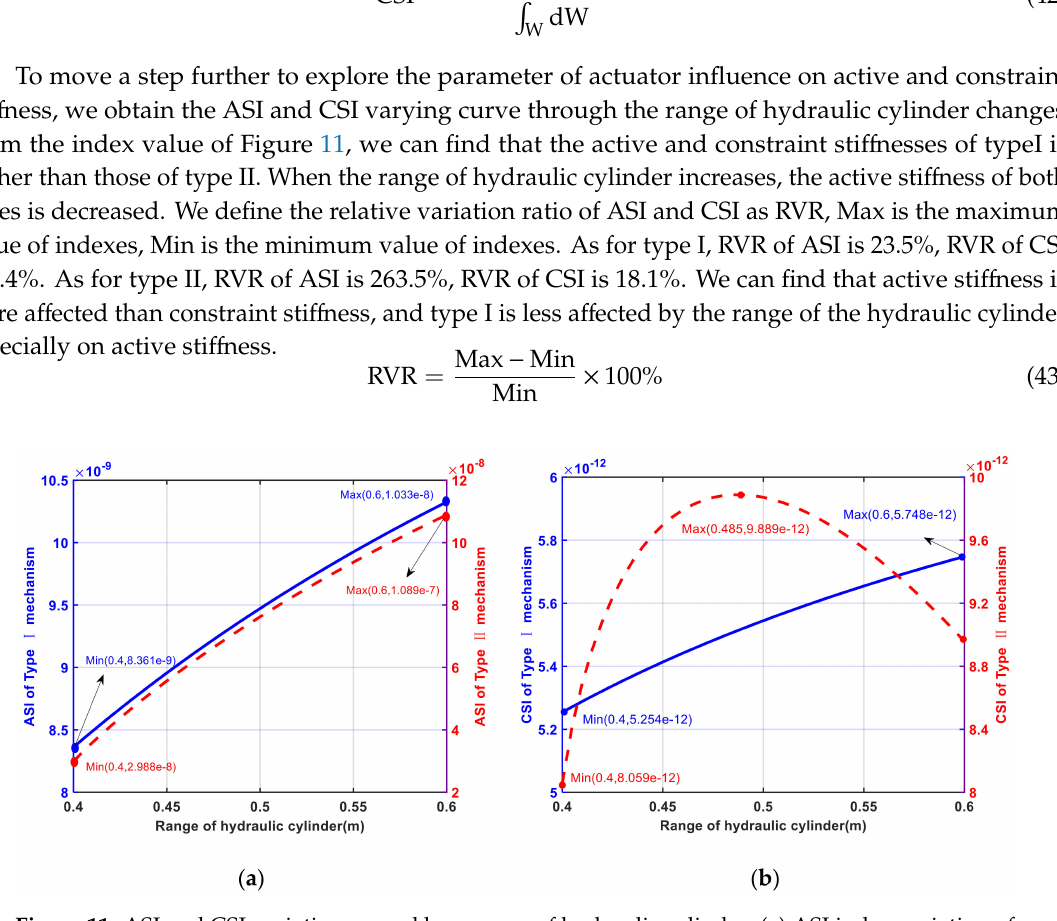
Figure 11. ASI and CSI variation caused by a range of hydraulic cylinder. ( a ) ASI index variation of two type mechanisms; ( b ) CSI index variation of two type mechanisms; The blue solid line stands for index of type I mechanism, the red dashed line stands for index of type II